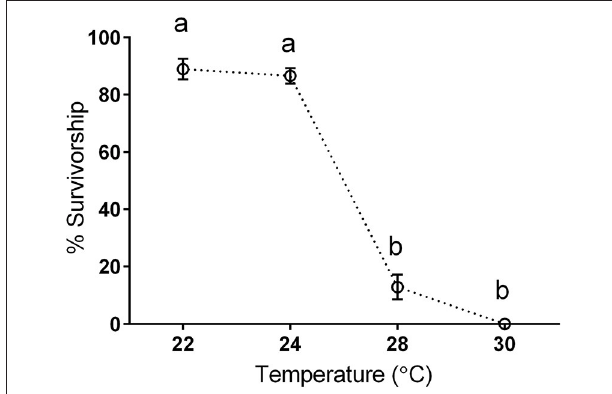
FIGURE 1 | Survivorship of N. triangulifer full life cycle rearing at different temperatures (modified from Kim et al., 2017). Each point represents the mean survival from rearing jars [22 ◦ C ( n = 11) 24 ◦ C ( n = 10), 28 ◦ C ( n = 5), and 30 ◦ C ( n = 11)] with 50 larvae/jar to begin with. Error bars represent standard deviations from the means. One way ANOVA was performed and Tukey’s multiple comparisons test was used to analyze the differences of survivorship between temperatures. Different lowercase letters suggest significant differences of survivorship between temperatures.